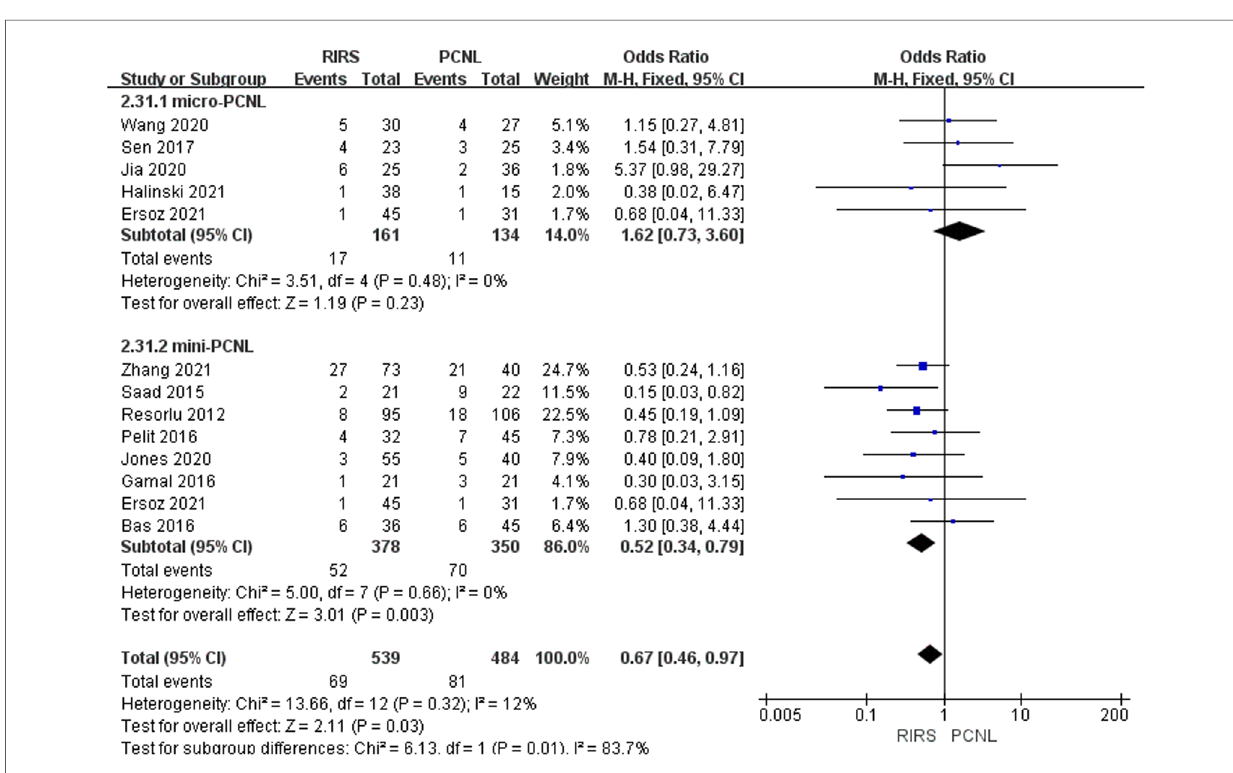
FIGURE 12 Forest plot of pooled postoperative complication between the RIRS group and PCNL